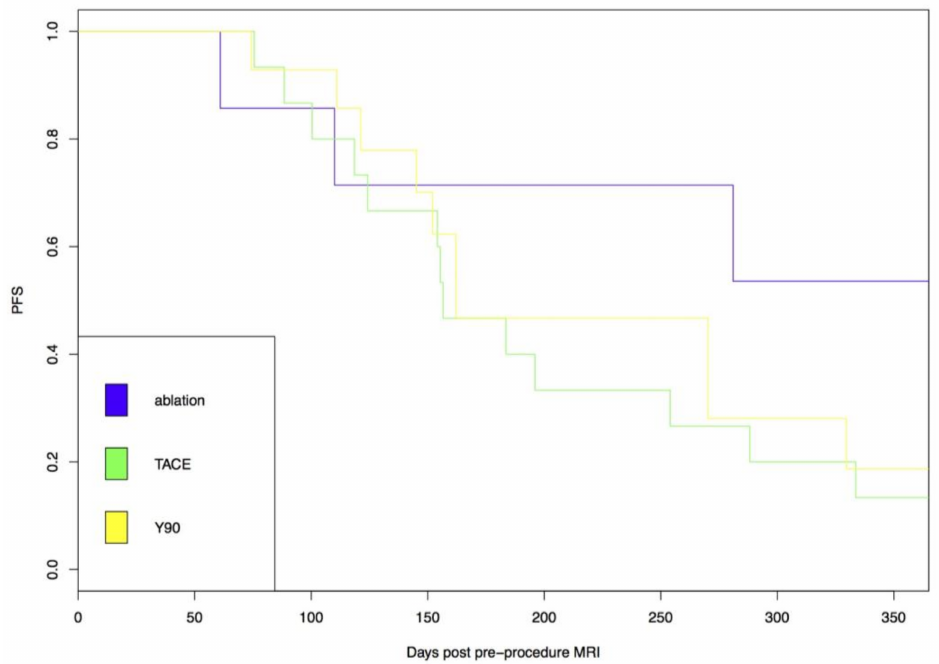
Figure 3. Index lesion specific progression free survival (PFS) was no different following drug eluting embolic (DEE), chemoembolization or radioembolization in low apparent diffusion coefficient (ADC)